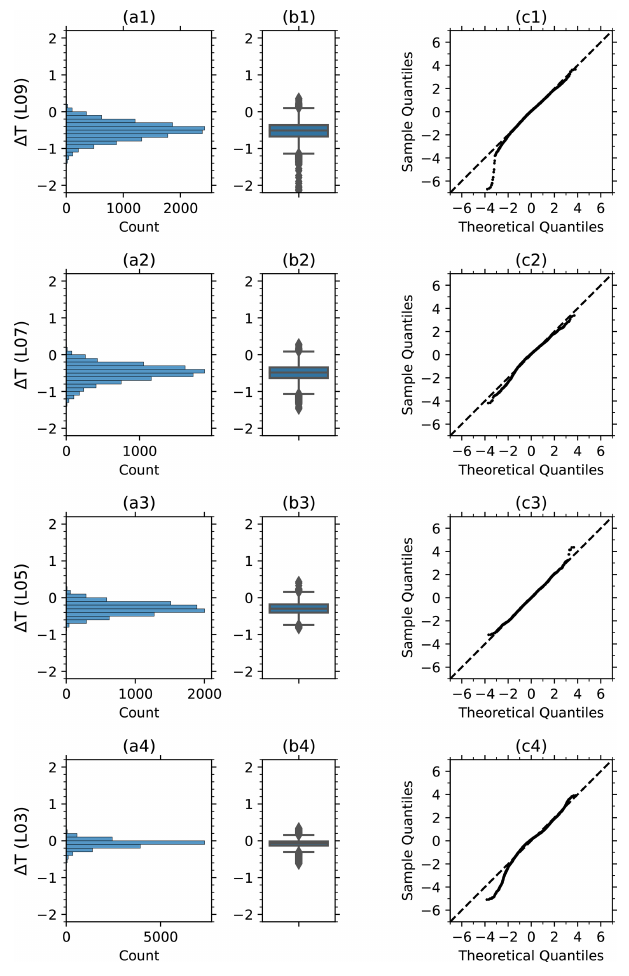
Figure 20. Distribution of temperature differences for daytime ob- servations. aX is the histogram, bX is the box plot, and cX is the quantile–quantile plot. X indicates the layer for (1) L09 (50– 30hPa), (2) L07 (100–70hPa), (3) L05 (200–150hPa), and (4) L03